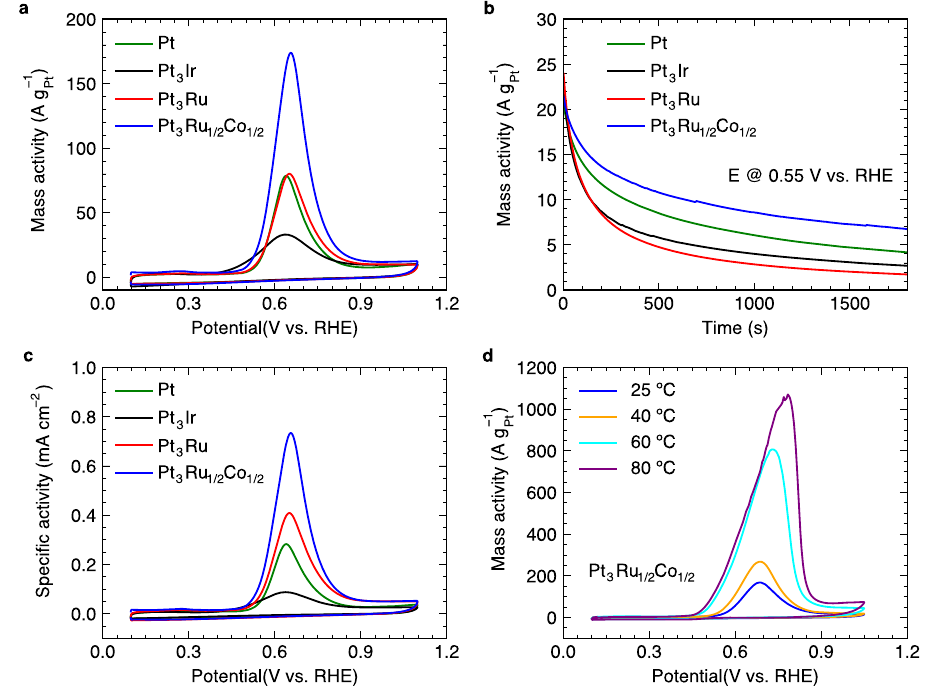
Fig.4|NH 3 electrooxidationperformance.a Electrocatalyticperformancetesting ofthePt,Pt 3 Ir,Pt 3 RuandPt 3 Ru 1/2 Co 1/2 nanocubesviacyclicvoltammetry(CV)with a rotating speed of900rpm in Ar-saturated 1.0M KOH+0.1M NH 3 underambient conditions. b The NH 3 electrooxidation short-term stability of the Pt, Pt 3 Ir, Pt 3 Ru and Pt 3 Ru 1/2 Co 1/2 nanocubes at 0.55V vs. RHE using the same testing conditions.